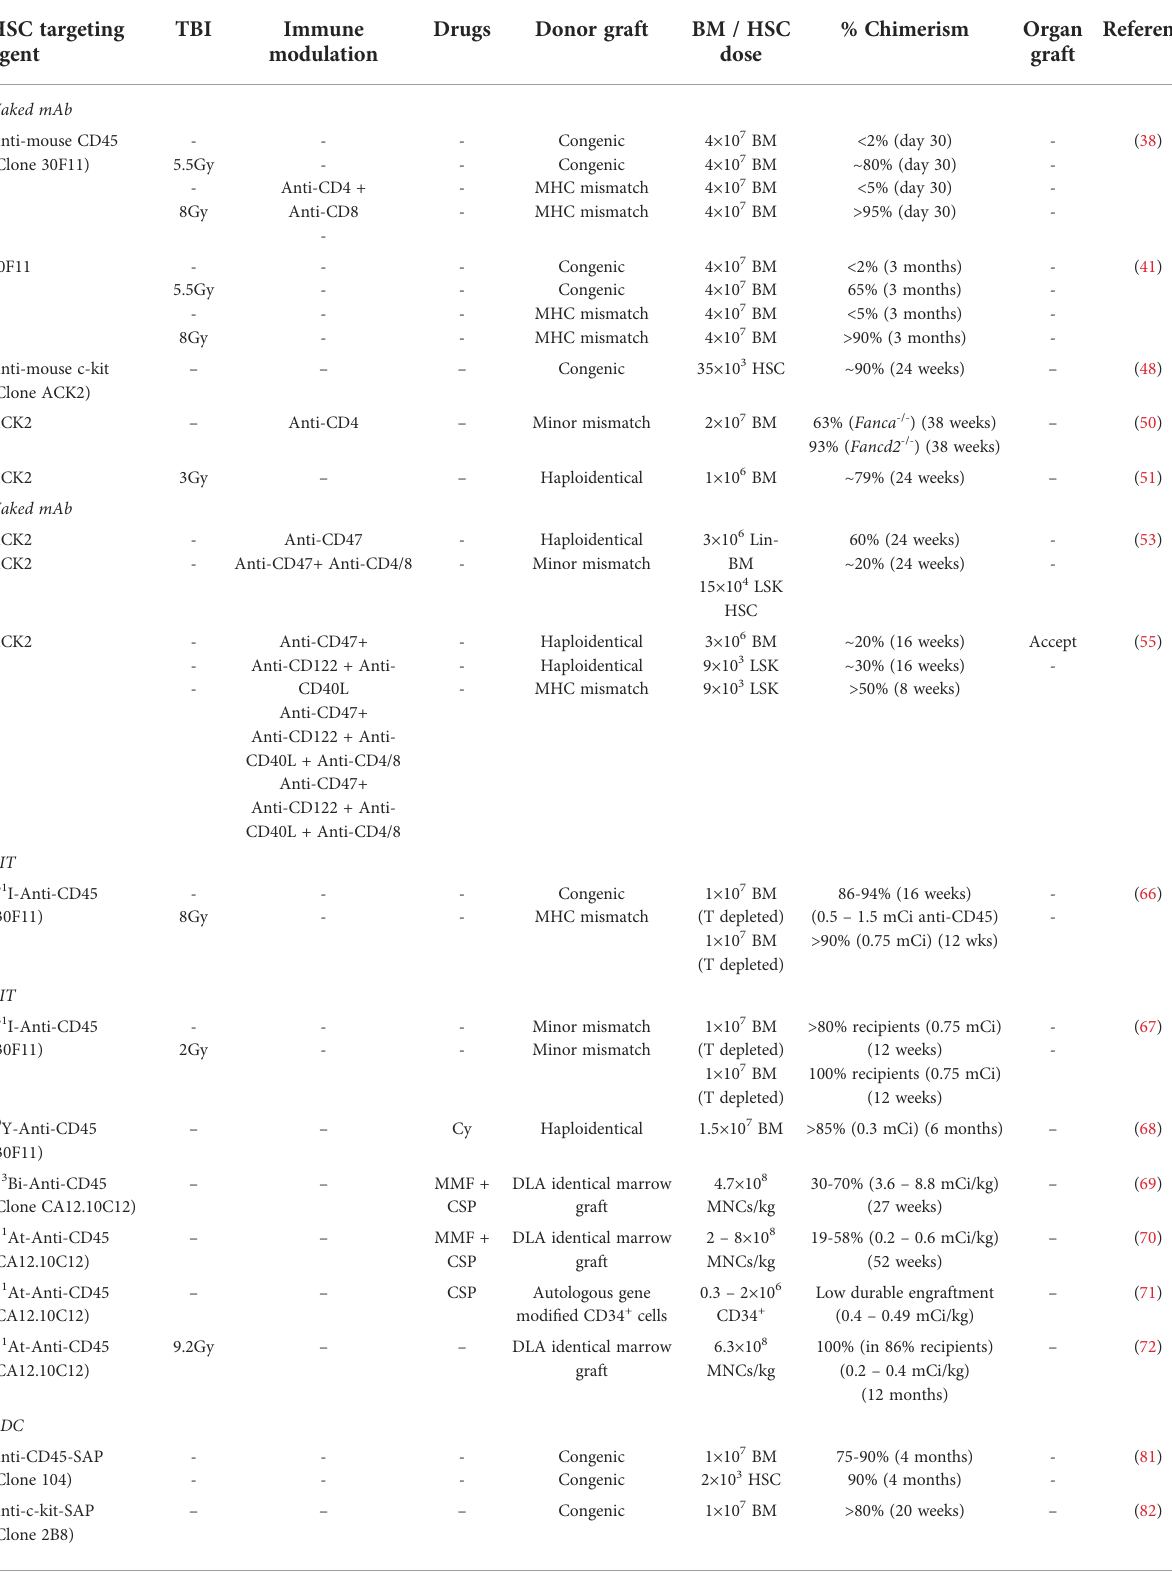
TABLE 1 Antibody-based approaches for hematopoietic stem cell